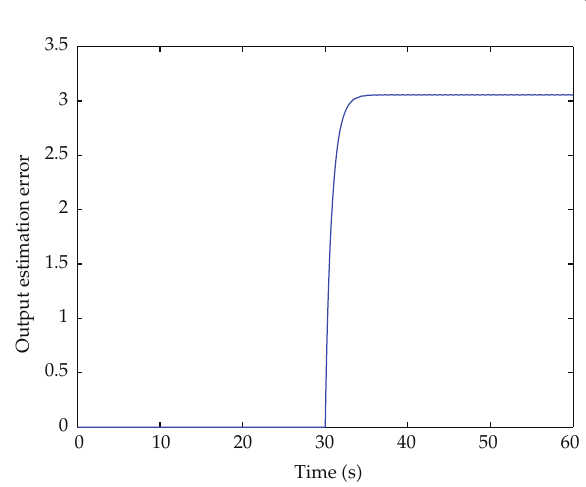
Figure 6: Output estimation error in case 3 using a low frequency